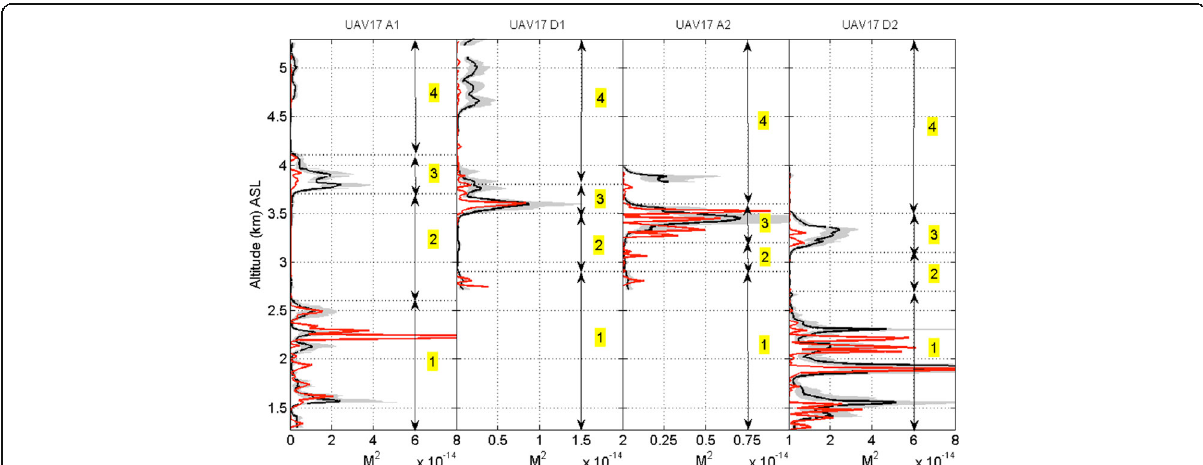
Fig. 8 Comparisons between M 2 ( red ) and M 2 ( black ) profiles in linear scales for A1, D1, A2, and D2 flight phases of UAV17. The labels (1) to UAV radar (4) refer to the region emphasized in Fig. 5b. Horizontal scales have been adapted to the dynamics of the values